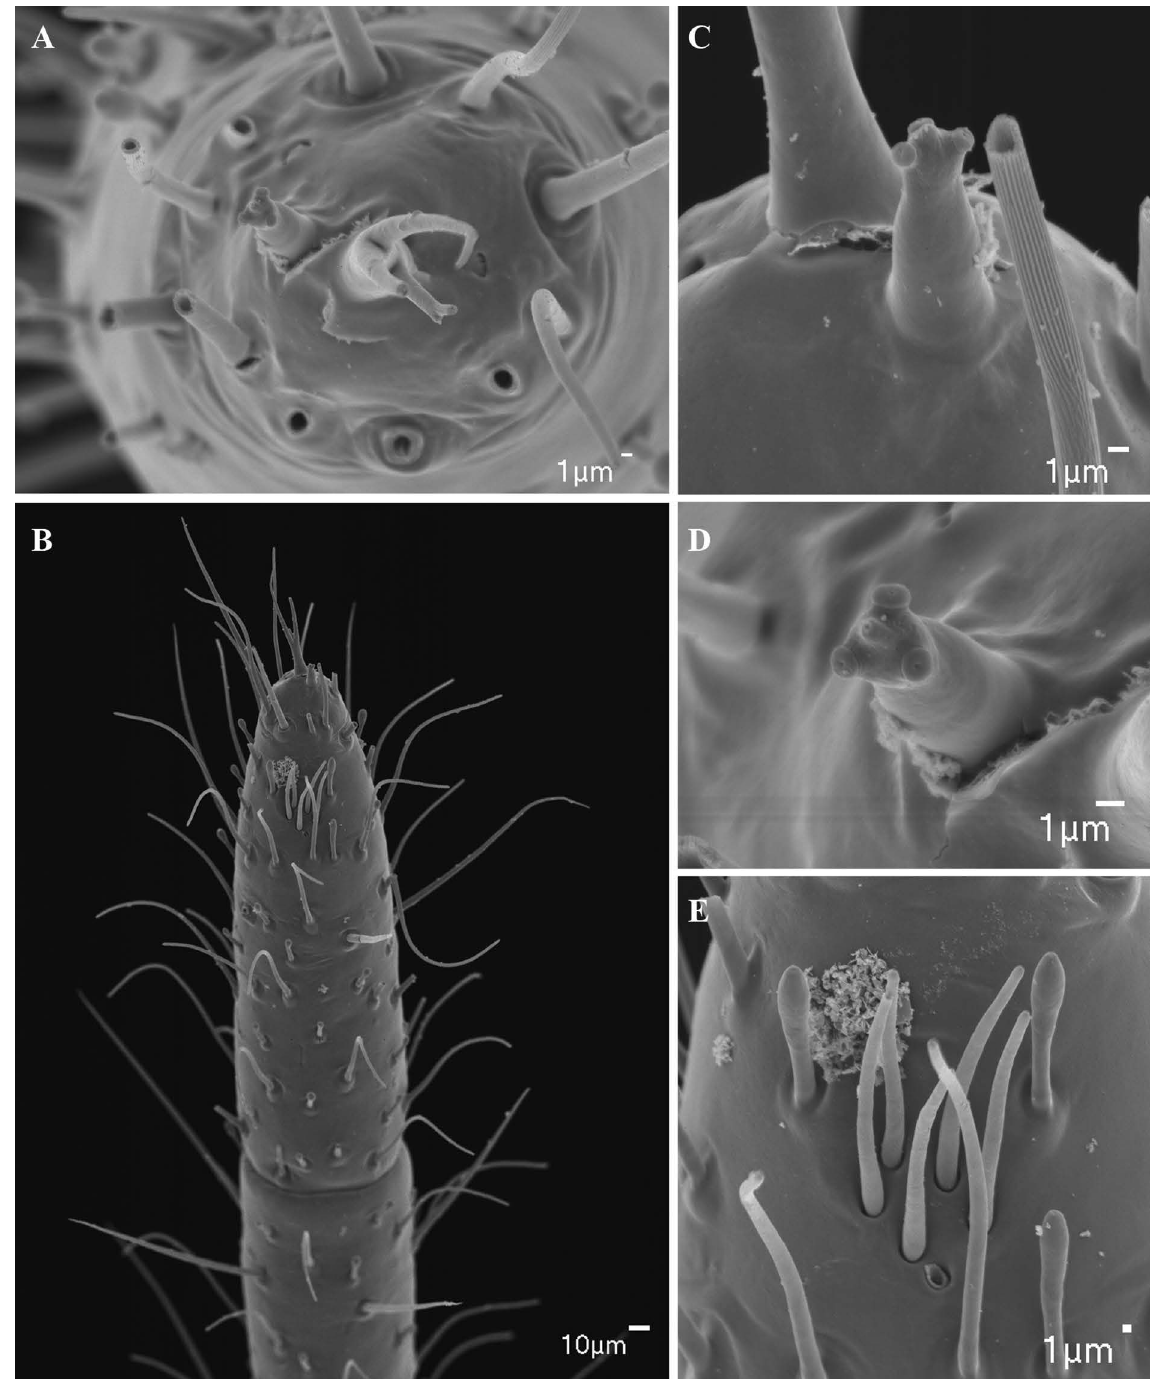
Fig. 116. Sarax javensis (Gravely, 1915) (WAM T80541), antenniform leg I, ♀. A . Apex of distal article. B . Distal segment of tarsus, lateral view. C–D . Detail of tarsal organ. E . Rod sensilla and olfactory